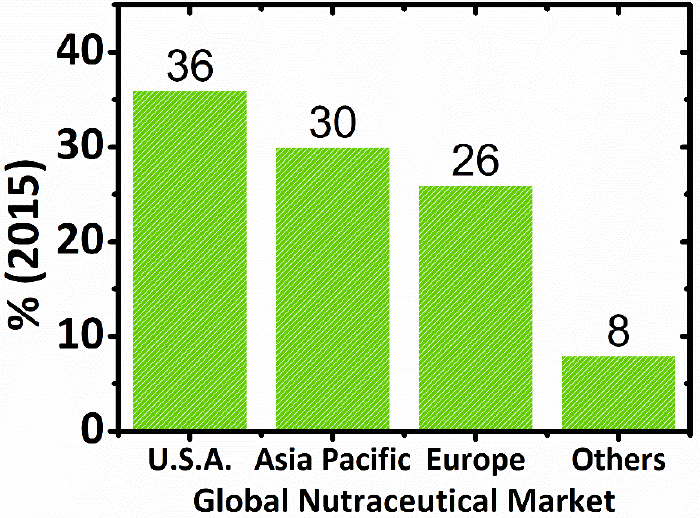
Figure 3. Global Nutraceutical Market by Region (%) in 2015: U.S.A. (36%), Asia Pacific (30%), Europe (26%), and others include the rest of the world (8%) [83].